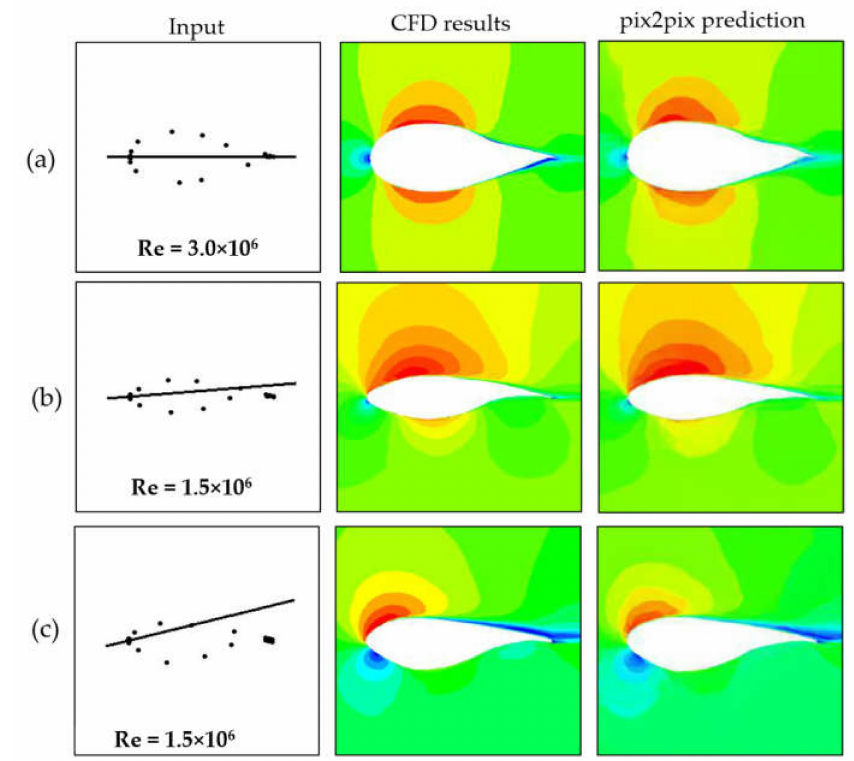
Figure 7. Prediction results of pix2pix for the flow fields of three airfoil shapes at constant angles of attack of 0 ◦ , 5 ◦ , and 15 ◦ and Reynolds numbers of 3.0 × 10 6 , 1.5 × 10 6 , and 1.5 × 10 6 , respectively: ( a ) DU 00-W2-401, ( b ) DU 97-W-250, and ( c ) DU